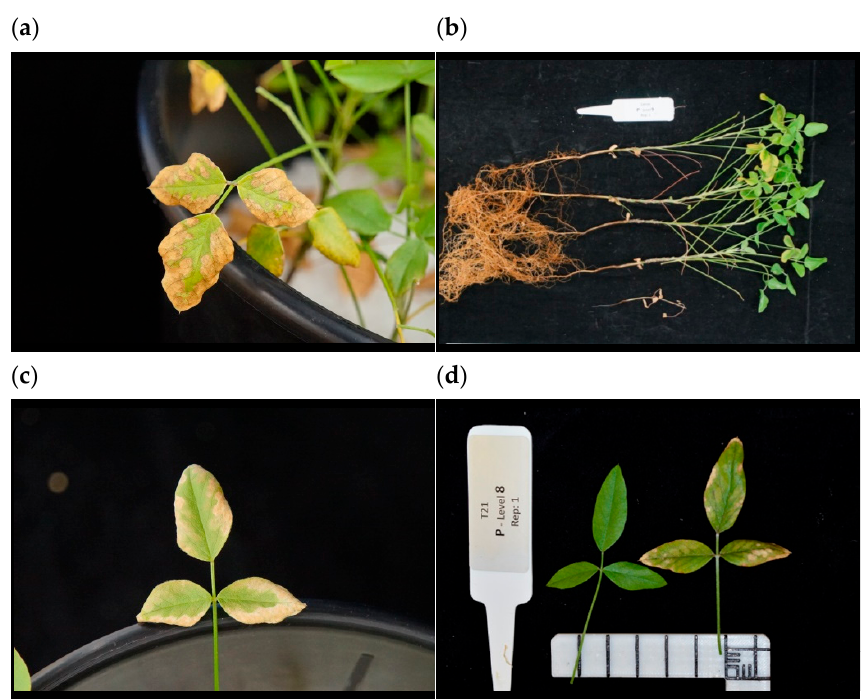
Figure 7. Images of leaves taken from Lanza ® tedera ( a ), whole Lanza ® plants ( b ) and Palma ( c , d ) grown in soils with toxic levels of soil phosphorus (ca. 80 mg kg − 1 Colwell P).